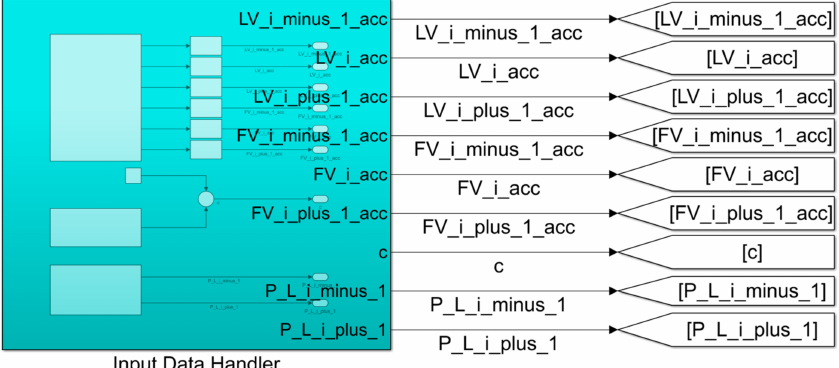
Figure 7. Input handler subsystem overview—implementation using Simulink (MATLAB